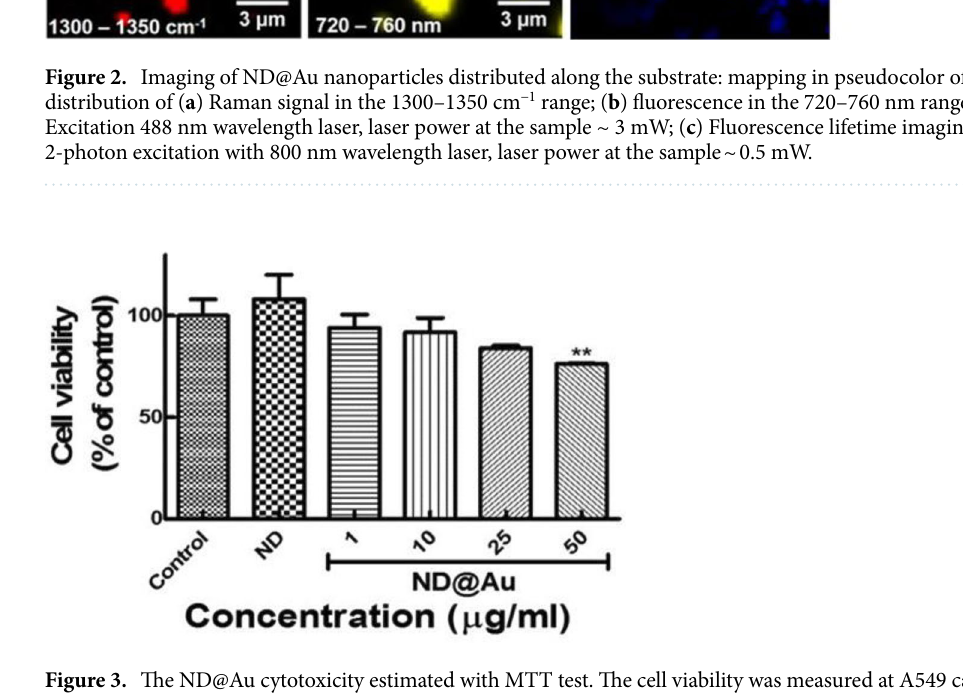
Figure 3. The ND@Au cytotoxicity estimated with MTT test. The cell viability was measured at A549 cancer cell incubation with various concentrations of ND@Au and ND for 24 h. Control is non-treated A549 cell culture. n = 6, (three experiments were repeated twice), ns, P > 0.05 was considered not significant, **P < 0.01. Data are mean ±